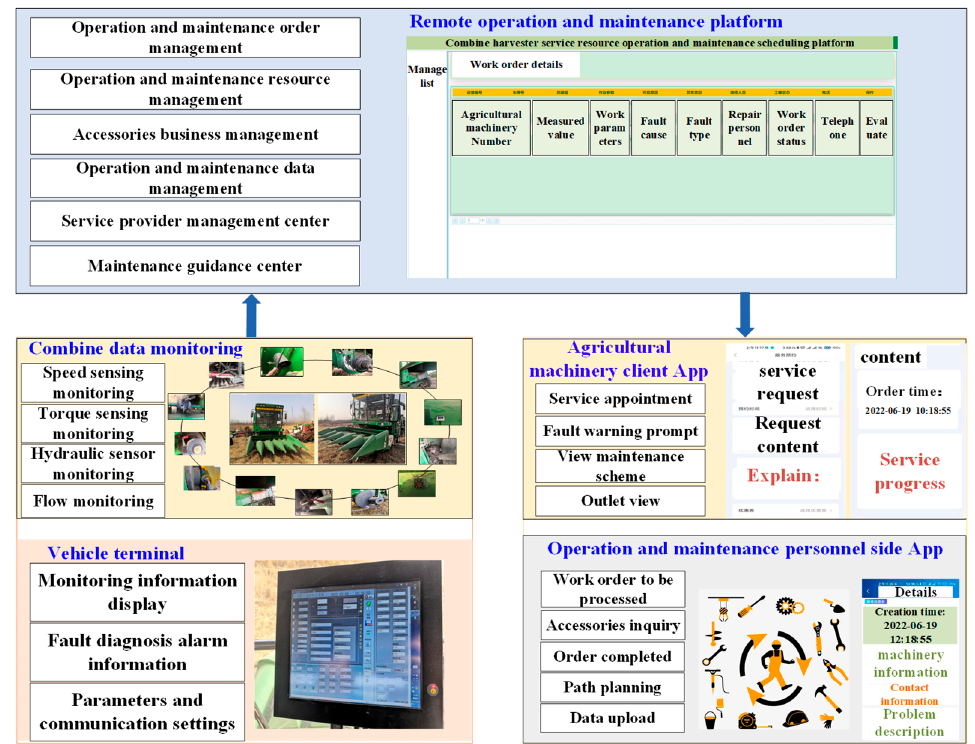
Figure 6. Comprehensive operation and maintenance service platform.